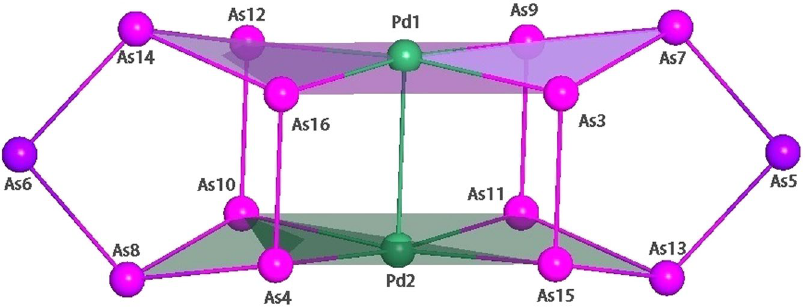
Figure 1. Optimized D 2 h structure of [Pd 2 As 14 ] 4 − ( 1 ) cluster at the PBE0/def2-TZVP level. Bond distances (in Å): As-As, 2.38–2.46; Pd-Pd, 2.75; As-Pd, 2.50. Bond angles (in degrees): ∠ AsPdAs, 76.30–172.68; ∠